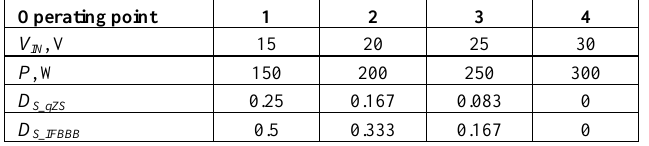
I NPUT V OLTAGE AND P OWER IN THE S ELECTED O PERATING P OINTS